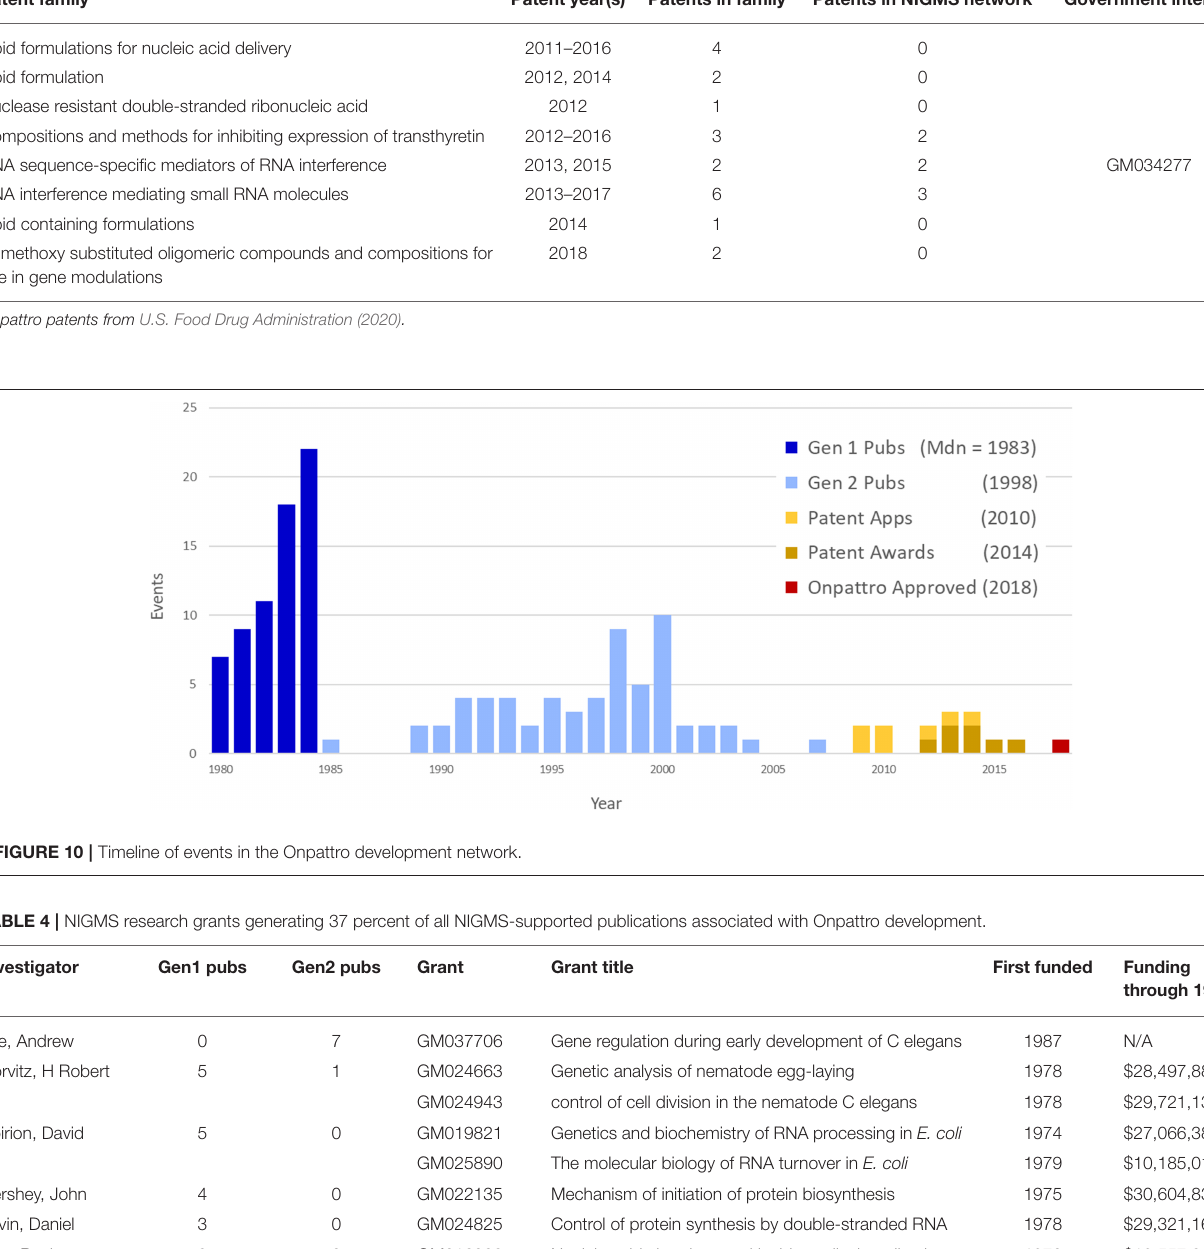
TABLE 3 | Onpattro patent families and number found in the NIGMS network. Patent family